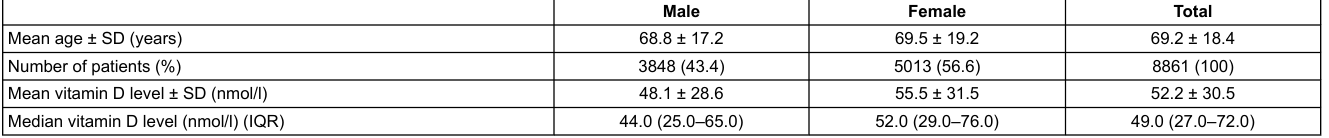
Table 1: Patient characteristics and vitamin D concentrations according to gender.